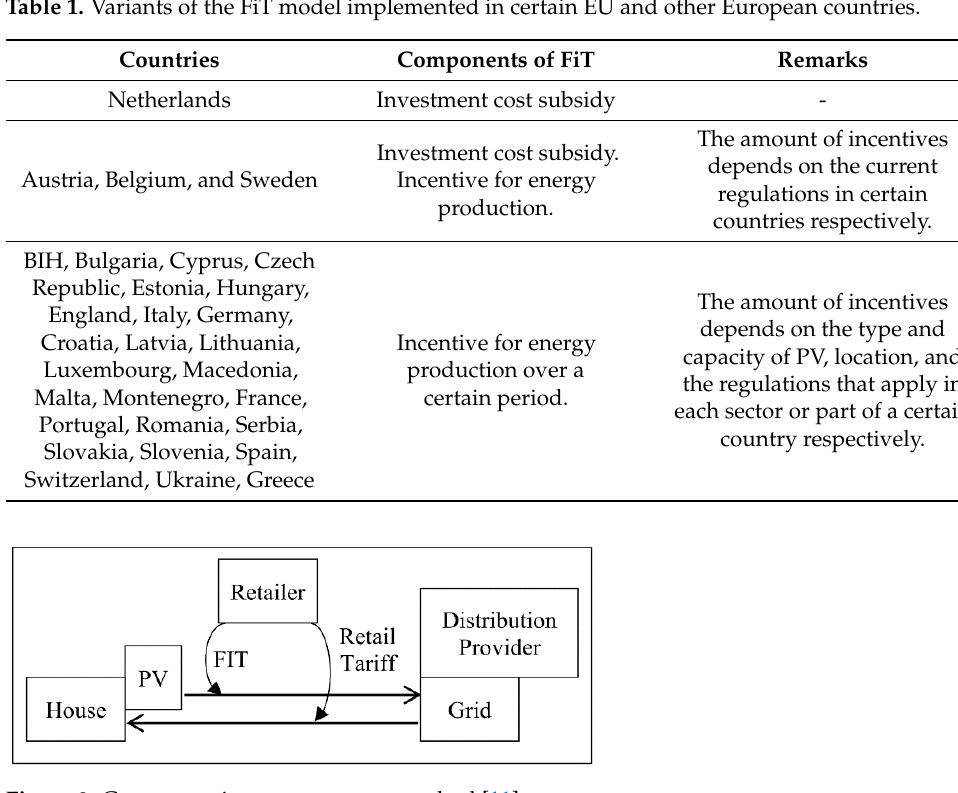
Table 1. Variants of the FiT model implemented in certain EU and other European countries.